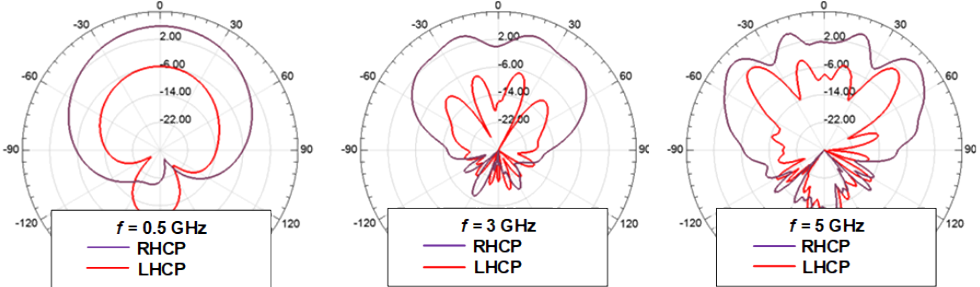
Figure 10. Sample plots comparing the right-hand circular polarization (RHCP) and left-hand circular polarization (LHCP) gain patterns in the xz plane at: 0.5, 3 and 5